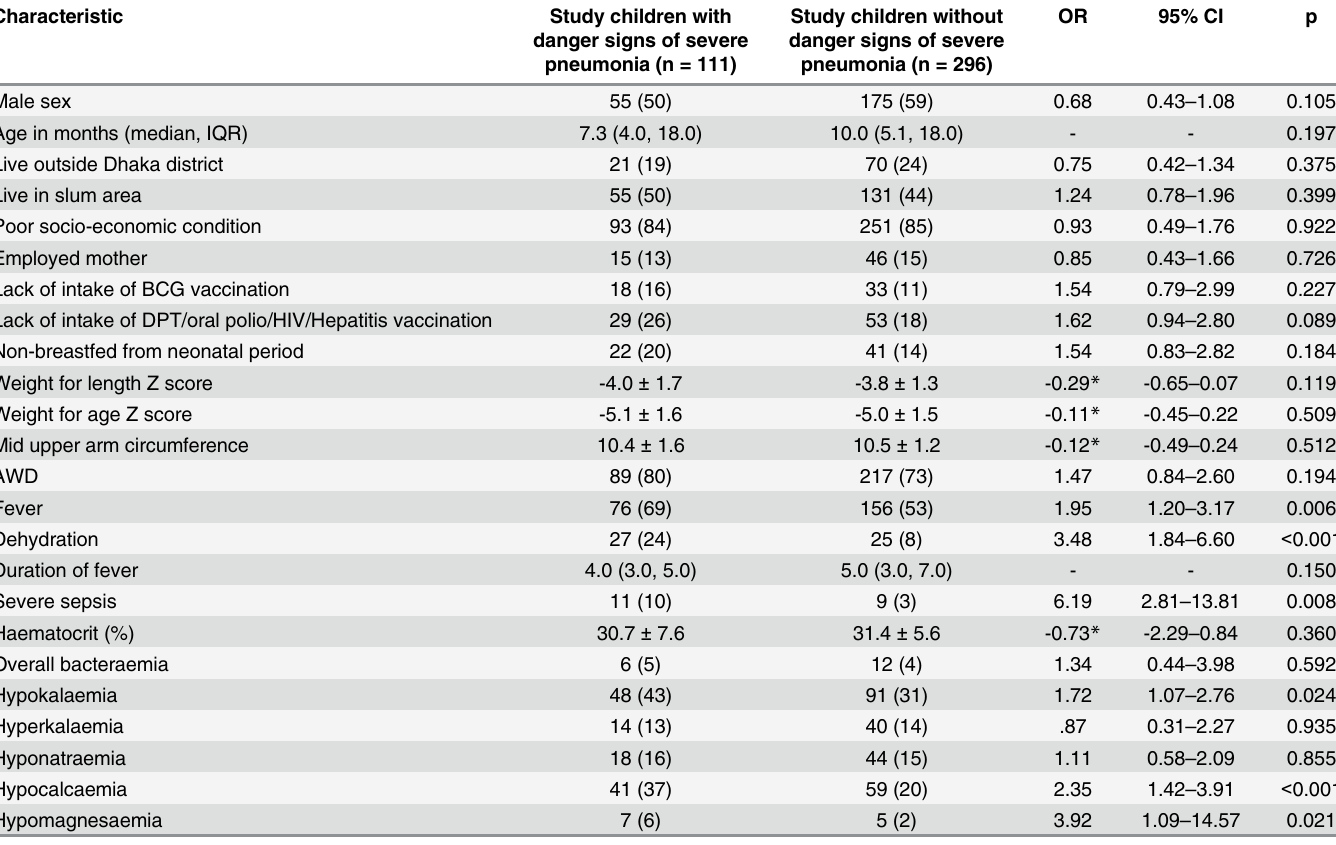
Table 1. Socio-demographic, clinical and laboratory characteristics of under-five, severely malnourished children with danger signs of severe pneumonia on admission who received standard WHO interventions and those without danger signs of severe